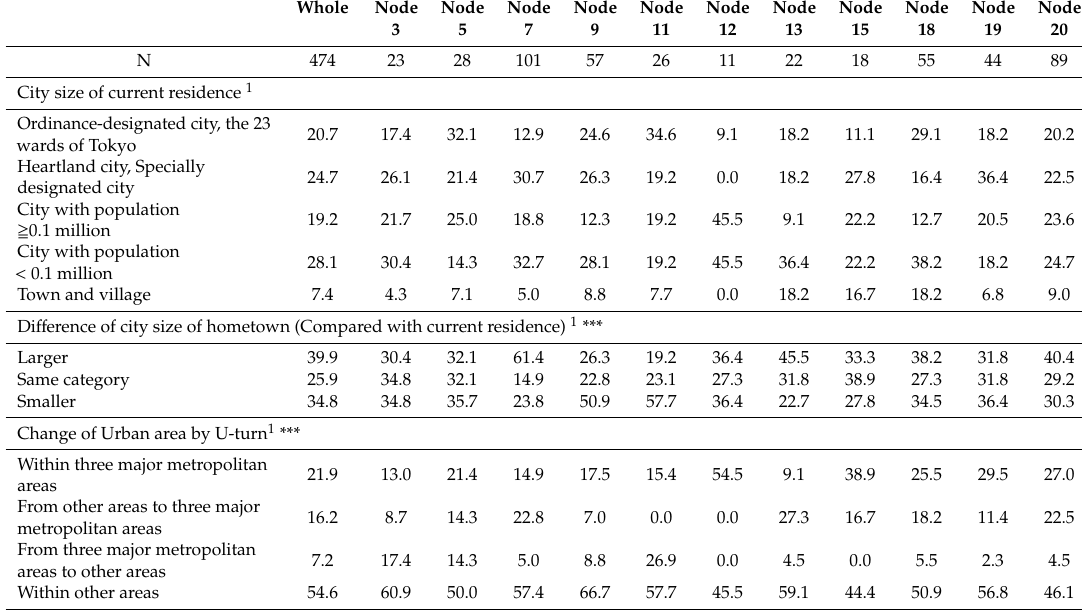
Table 9. Characteristics of the city of residence and hypothetical change after respondents’ U-turn. Whole